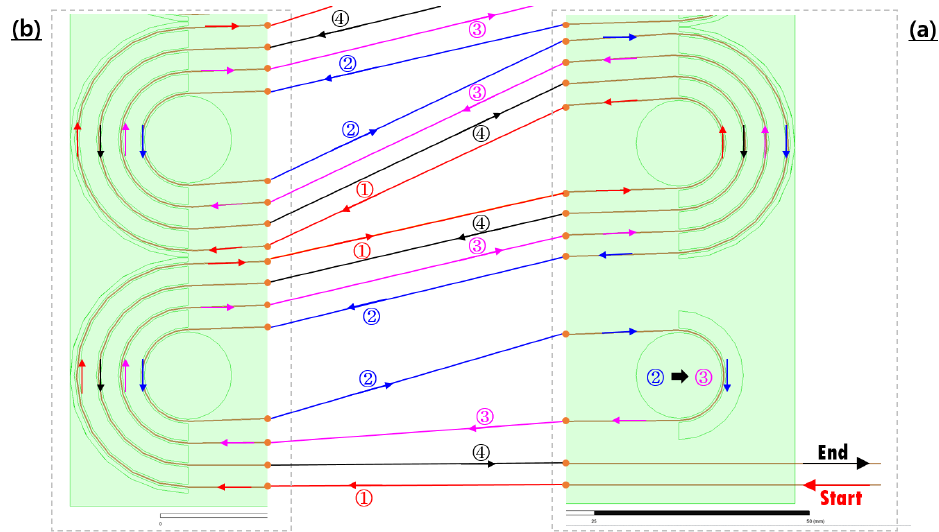
Figure 5. Winding flow diagram of ( a ) and ( b ) (bottom).